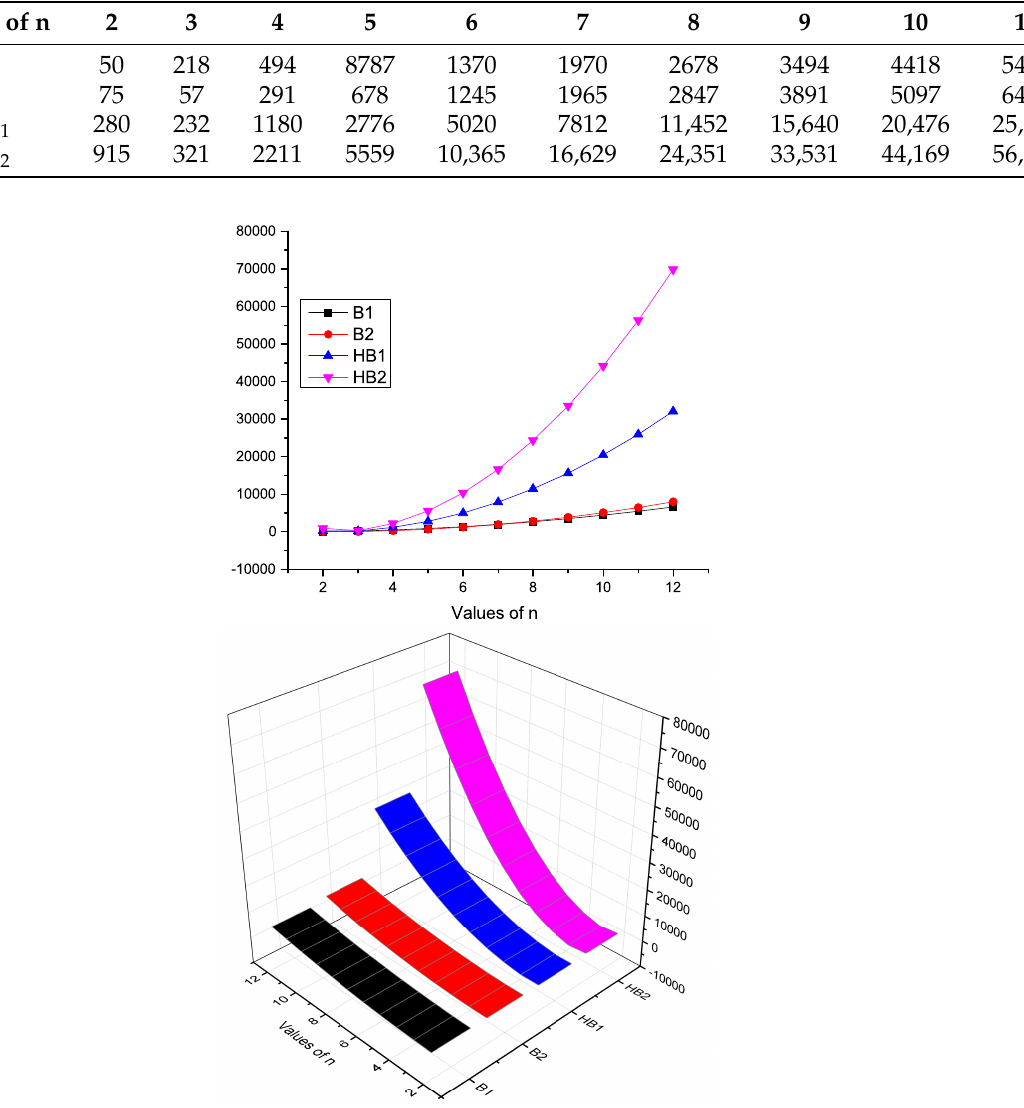
Figure 4. Graphical representation of K -Banhatti indices of CNB n